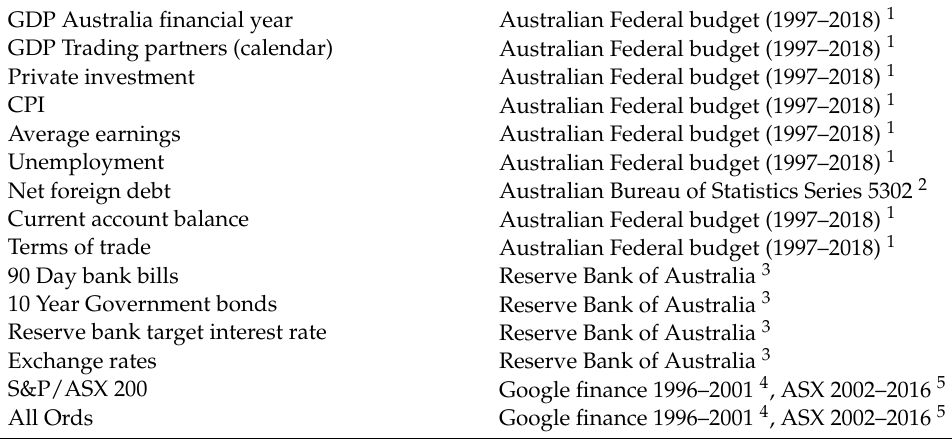
Table 2. Data sources (last accessed in 2020) for verification of each of the forecasts outcomes.